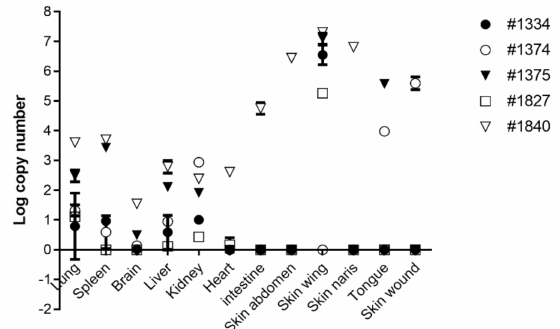
Figure 5. Detection of poxvirus nucleic acid in bats tissues. Molecular Detection of poxvirus copy number in tissues of diseased suckling bats by